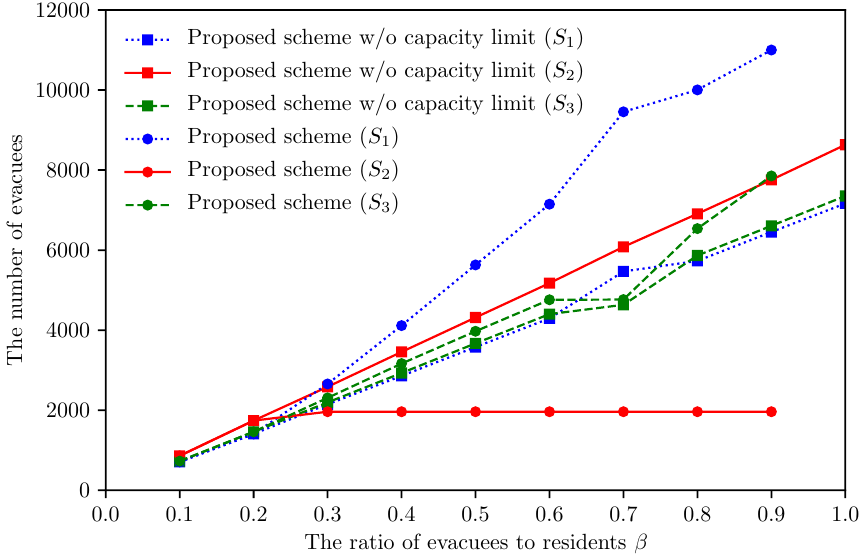
and f (proposed scheme vs. proposed scheme without capacity limit). d p